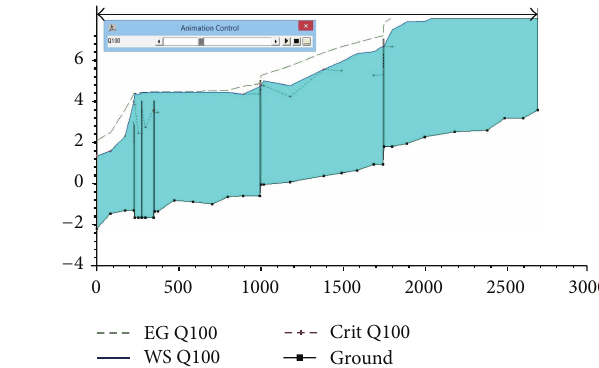
Figure 3: Water surface profile for the Q100